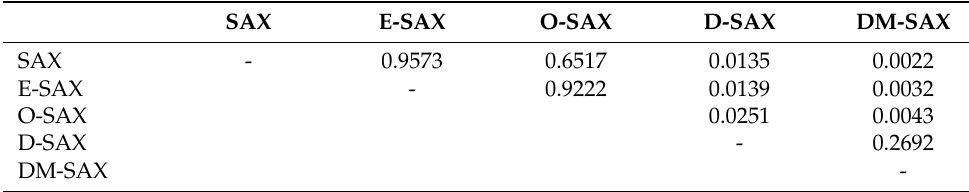
Table 4. Post-hoc test (Wilcoxon) results ( p